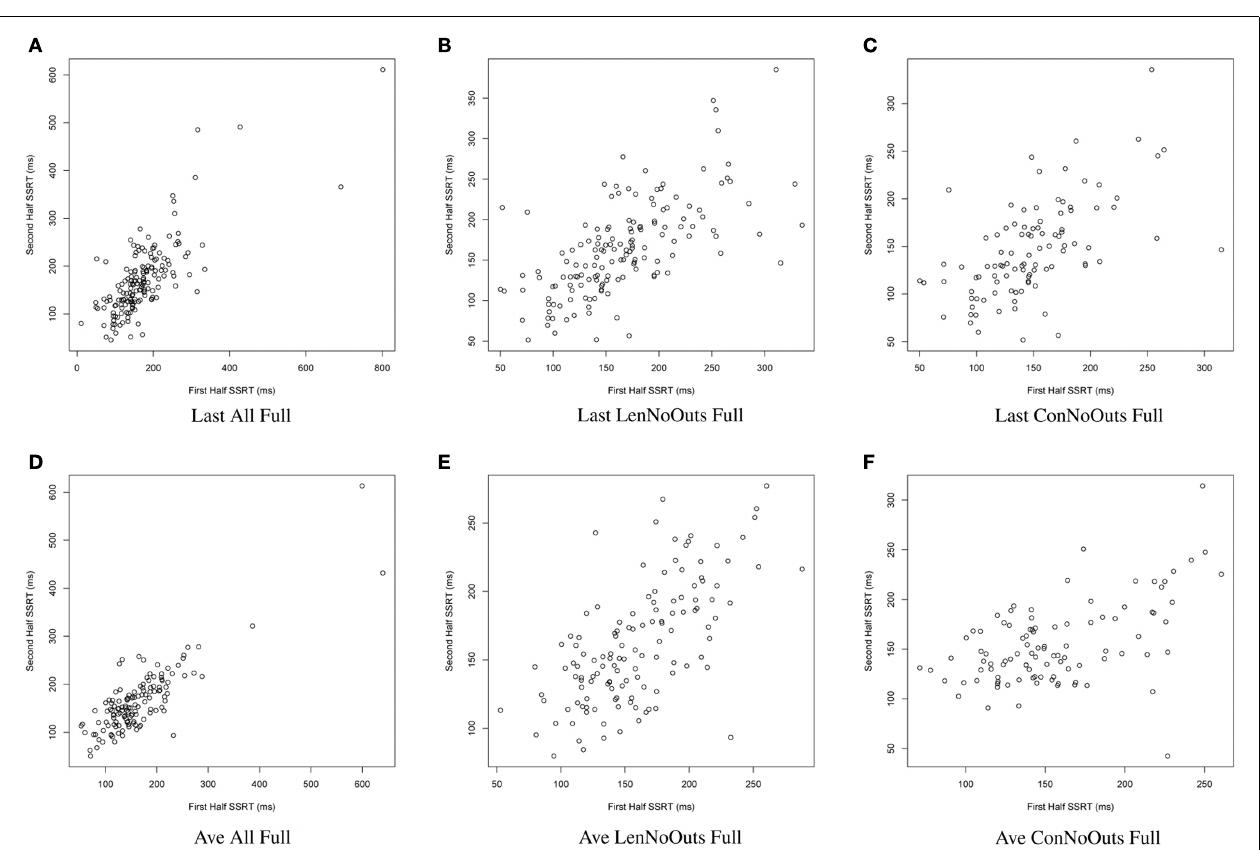
bottom row includes an average of all available runs.The first column includes all available subjects; the second column excludes those subjects exceeding Lenient Outlier criteria; and the third column excludes those subjects exceeding Conservative Outlier criteria. Each of these six approaches used all trials from the selected runs. SSRT, stop-signal reaction